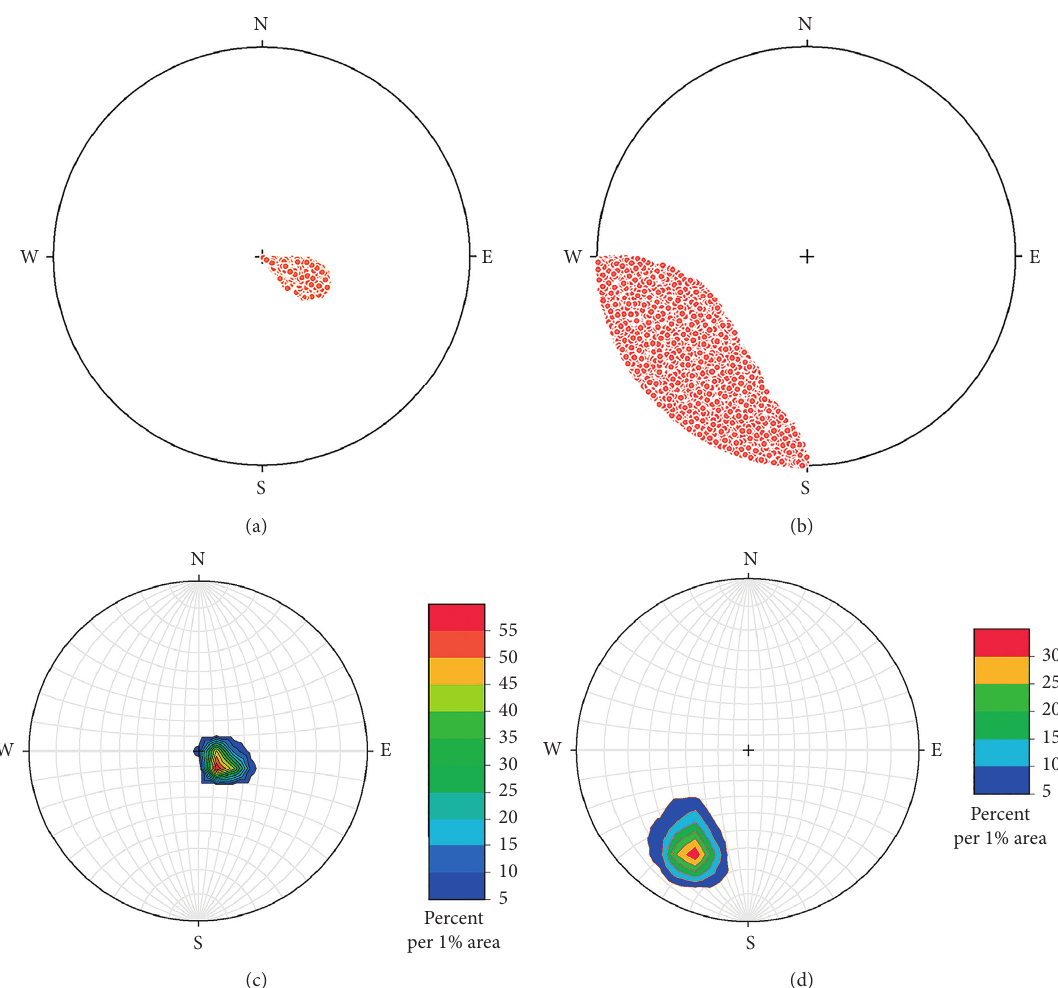
Figure 10: Scatter plot and the contour plot of the orient normal to polygons of detected joint sets. (a) Scatter plot of the orient normal to polygons of detected joint set 2 (plane 4). (b) Scatter plot of the orient normal to polygons of detected bedding plane (plane 8). (c) Contour plot of the orient normal to polygons of detected joint set 2 (plane 4). (d) Contour plot of the orient normal to polygons of detected bedding plane (plane